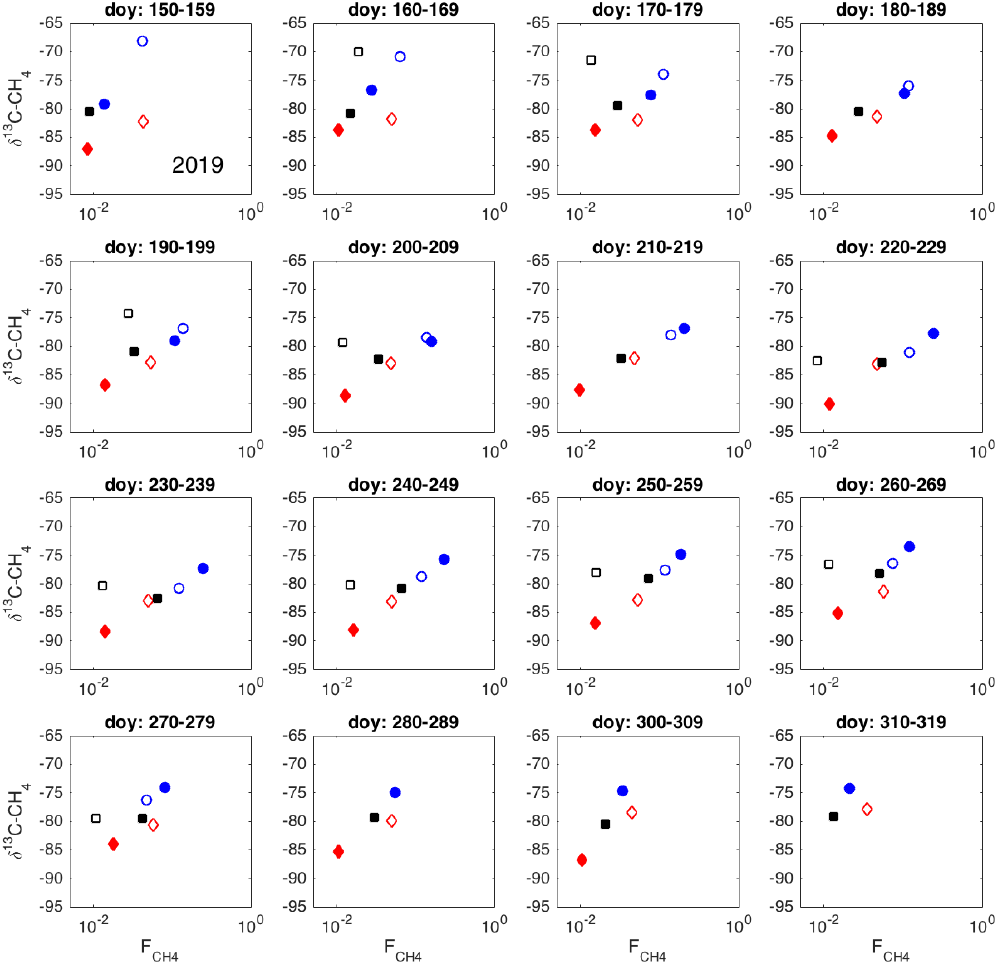
Figure A1. Spatial variation in δ 13 C-CH 4 against F CH circle; chamber 3: open black square; chamber 4: solid red diamond; chamber 5: open red square; chamber 6: solid black square.